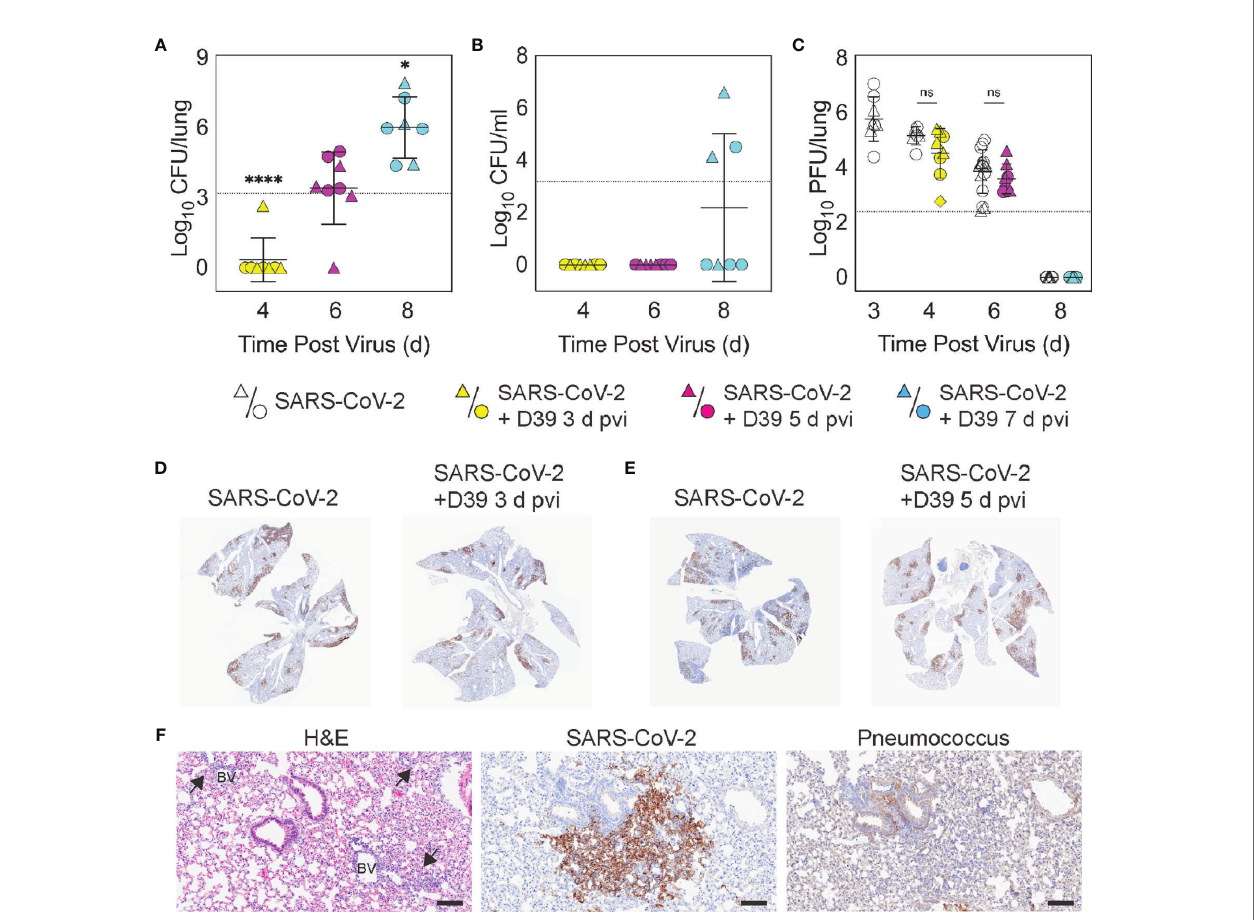
FIGURE 2 | Dynamics of pathogen loads during SARS-CoV-2 infection and pneumococcal coinfection. Lung bacterial loads (CFU/lung) (A) , blood bacterial loads (B) , and lung viral loads (PFU/lung) (C) in female (circles) and male (triangles) mice infected with SARS-CoV-2 (250 PFU; white) followed 10 3 CFU D39 at 3 d (yellow), 5 d (magenta), or 7 d (cyan) pvi. Each symbol represents a single mouse and the mean ± standard deviation (SD) are for combined male and female groups. Signi fi cant differences are indicated by ns, not signi fi cant; * P < 0.05; **** P < 0.0001. For bacterial titers, comparison was with the inoculum (dotted line). (D, E) Representative immunohistochemical (IHC) staining for SARS-CoV-2 nucleocapsid protein in whole lung sections following (24 h pbi) infection with SARS-CoV-2 (250 PFU) then PBS or 10 3 CFU D39 at 3 d (D) or 5 d (E) pvi. (F) Representative lung sections stained with H&E, SARS-CoV-2 nucleocapsid protein, or pneumococcus from infection with SARS-CoV-2 (250 PFU) followed by 10 3 CFU D39 at 5 d pvi. Lesions with perivascular in fl ammatory cell in fi ltration are indicated by arrows; blood vessel (BV). Scale bar = 100